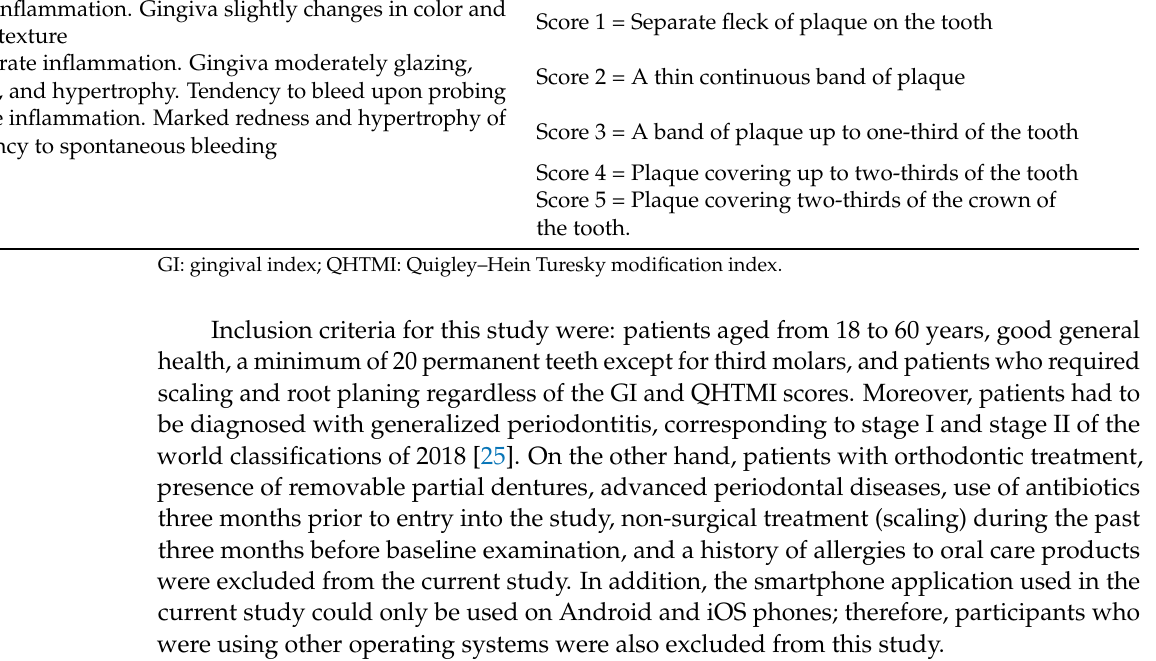
Table 1. GI and QHTMI scoring system. GI Score QHTMI Score Score 0 = No inflammation Score 0 = No plaque Score 1 = Mild inflammation. Gingiva slightly changes in color and Score 1 = Separate fleck of plaque on the tooth little change in texture Score 2 = Moderate inflammation. Gingiva moderately glazing, Score 2 = A thin continuous band of plaque redness, edema, and hypertrophy. Tendency to bleed upon probing Score 3 = Severe inflammation. Marked redness and hypertrophy of Score 3 = A band of plaque up to one-third of the tooth gingiva. Tendency to spontaneous bleeding Score 4 = Plaque covering up to two-thirds of the tooth Score 5 = Plaque covering two-thirds of the crown of the